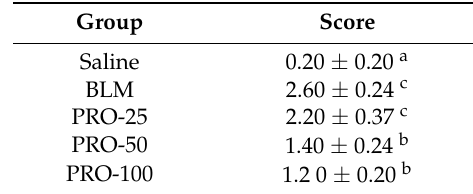
Table 3. Effect of the PRO on pathological score of pulmonary inflammation and fibrosis in BLM-treated